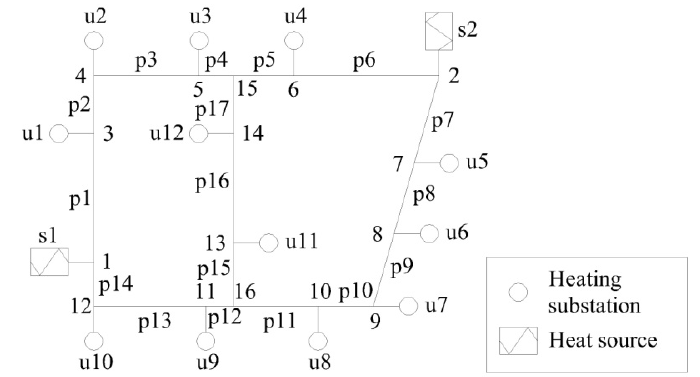
Figure 3. Schematic diagram of a simple actual HN.